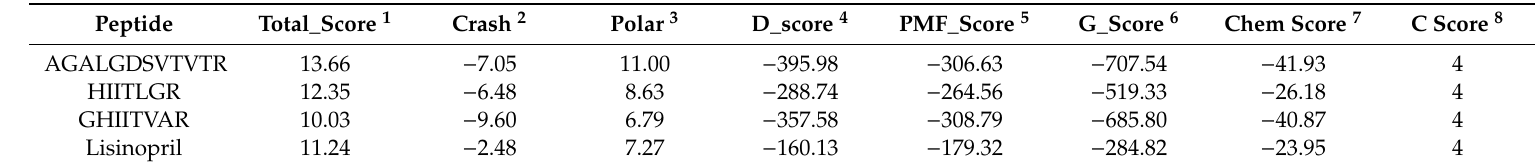
Table 4. Surflex-Dock scores (kcal / mol) of peptides and